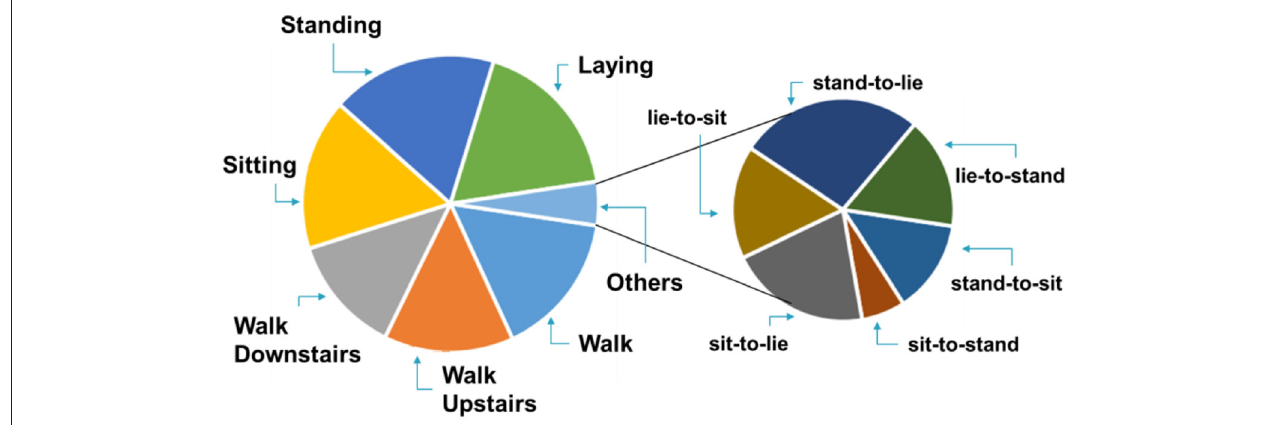
FIGURE 3 | HAPT dataset activity proportion chart.